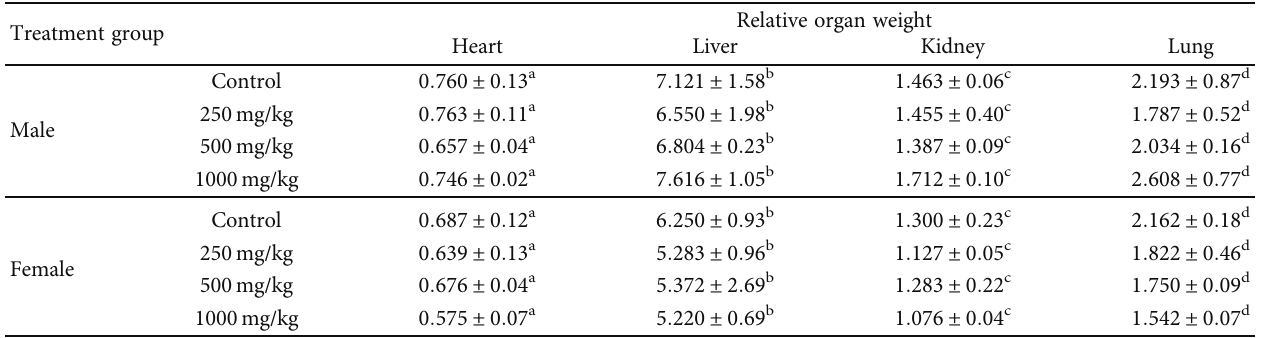
Table 5: E ff ect of the methanolic extract of Indigofera tinctoria on body organ weight after 28 days of treatment. Relative organ weight Treatment group Heart